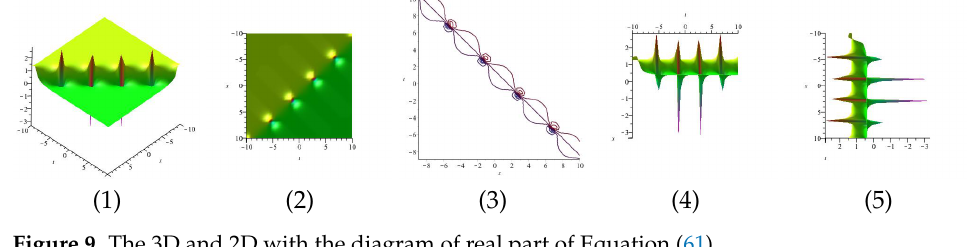
Figure 9. The 3D and 2D with the diagram of real part of Equation (61).